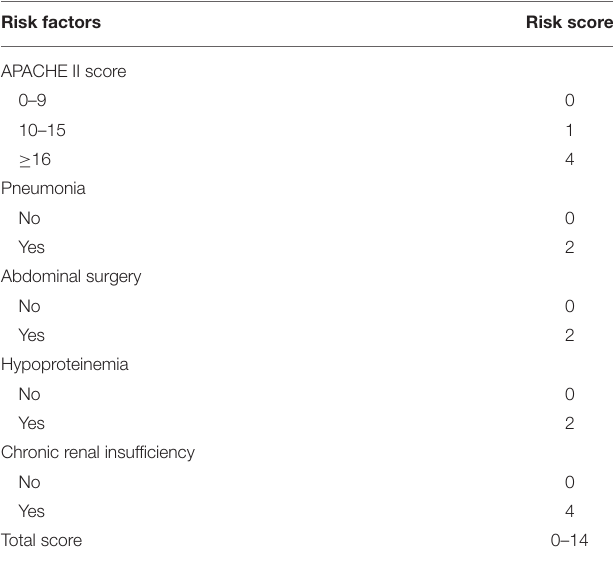
TABLE 4 | Risk scores corresponding to different risk factors for in-hospital death in patients with intra-abdominal infection.